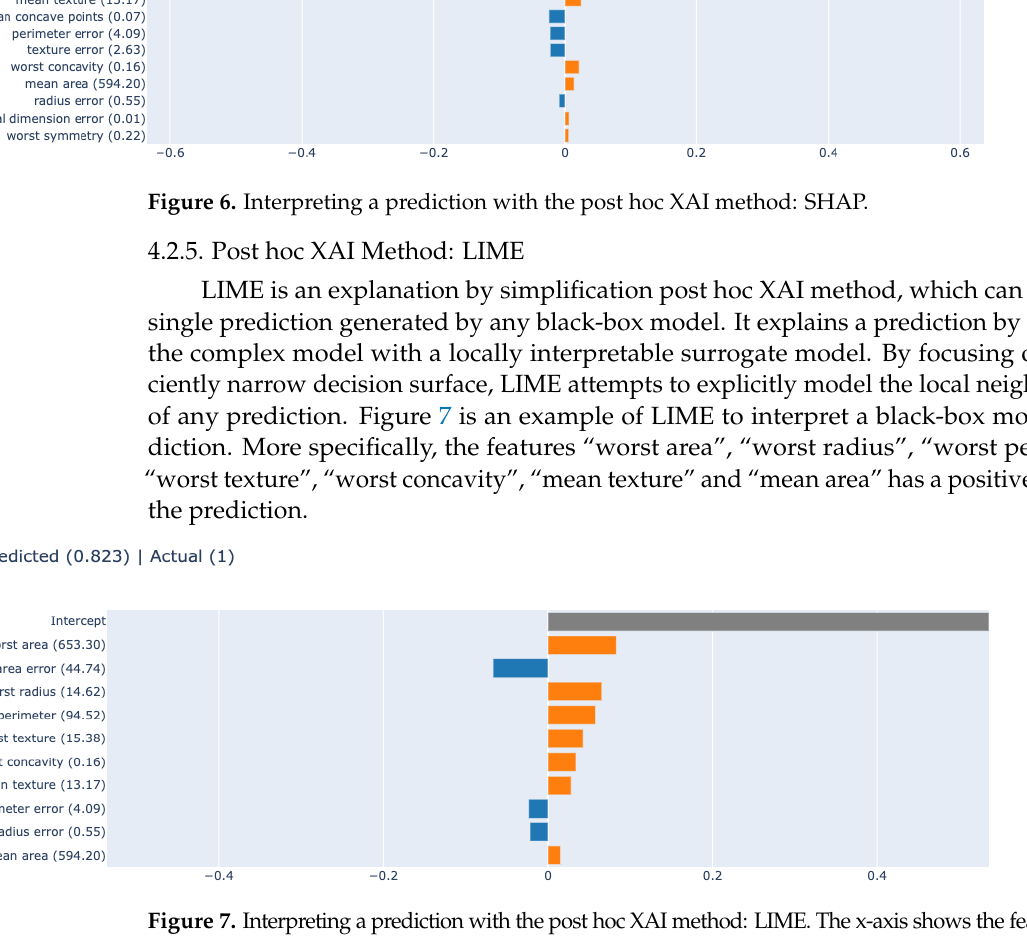
Figure 7. Interpreting a prediction with the post hoc XAI method: LIME. The x-axis shows the fea- ture